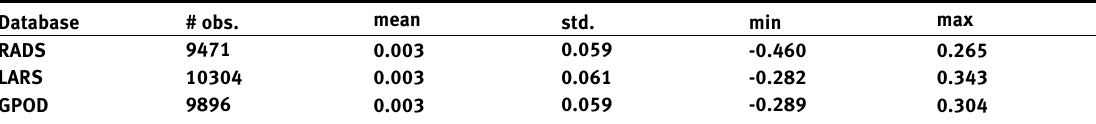
Table 1. Statistic of residual height anomalies after cross-over adjustment. Unit: m